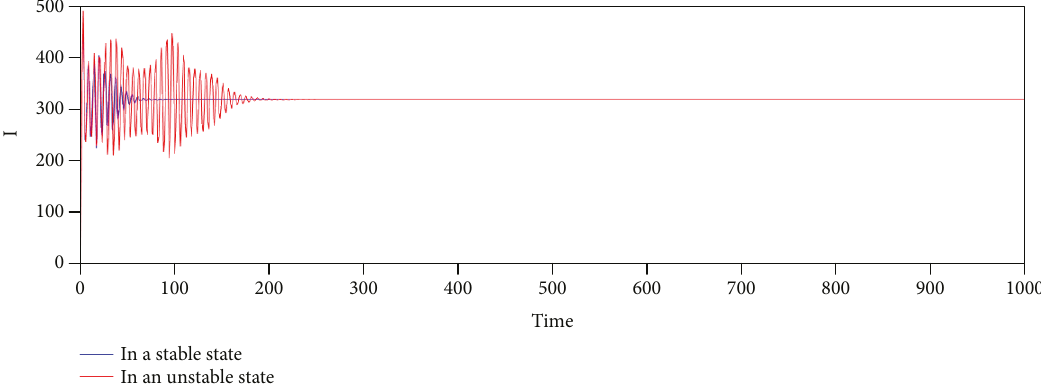
Figure 14: Comparison of initial inventory changes of the warehousing system in a stable state and unstable state under fi xed constant demand.